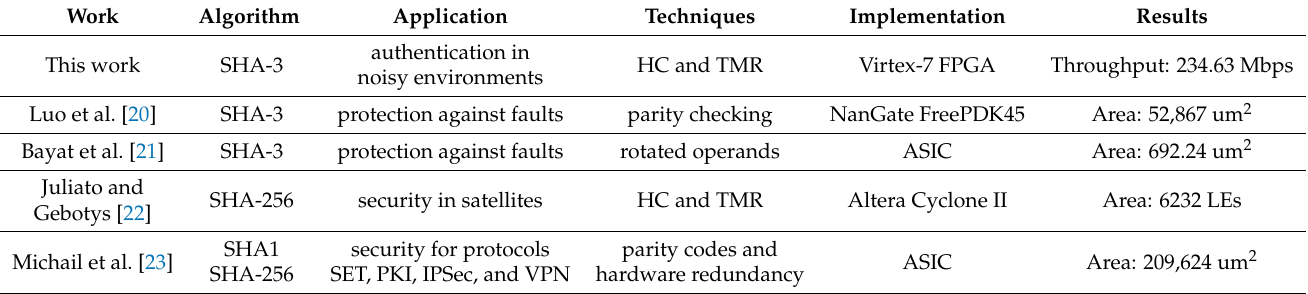
Table 1. Comparison with Related